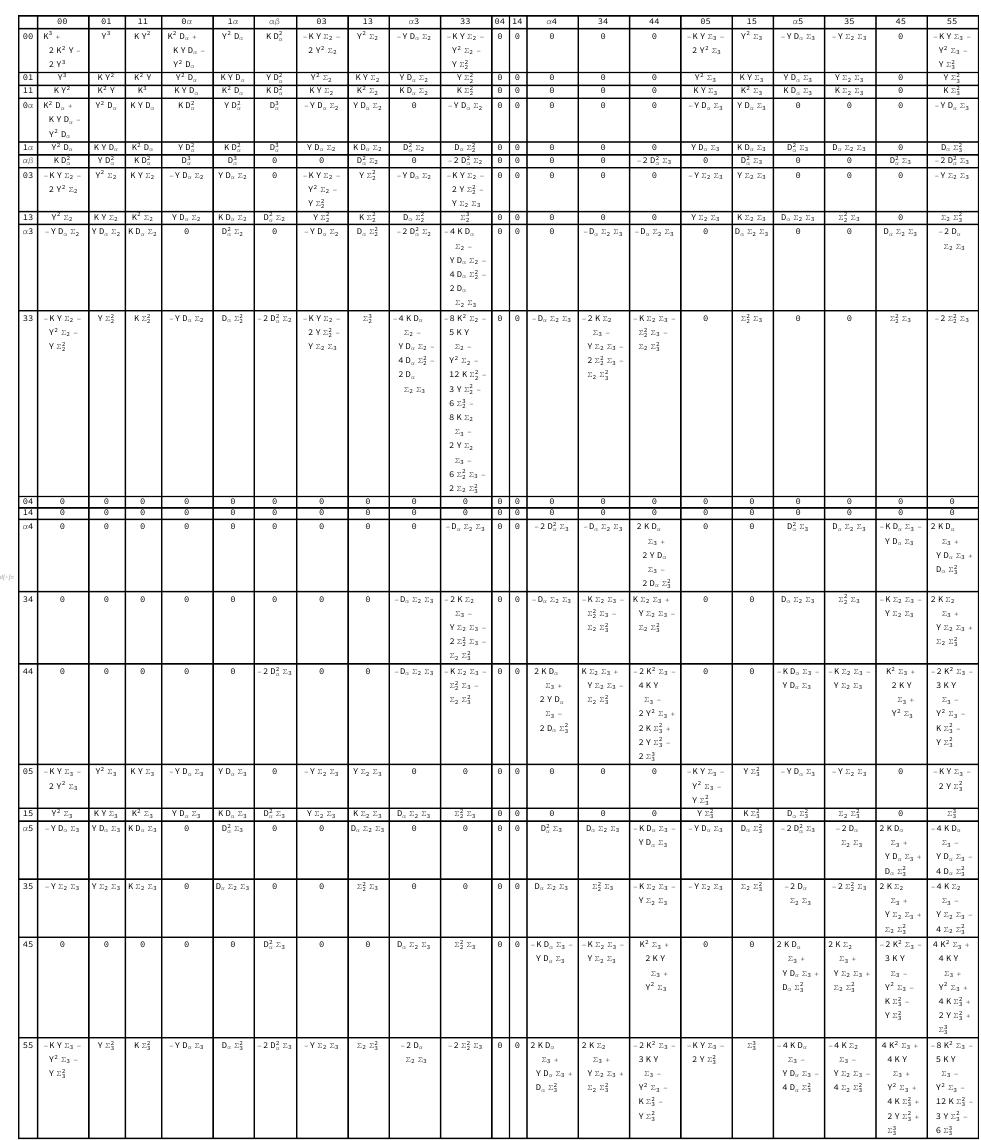
= S (recall IJ · S KL ( IJ )( KL ) ˆ D α is the pullback = D = 3 α · D β , D α α